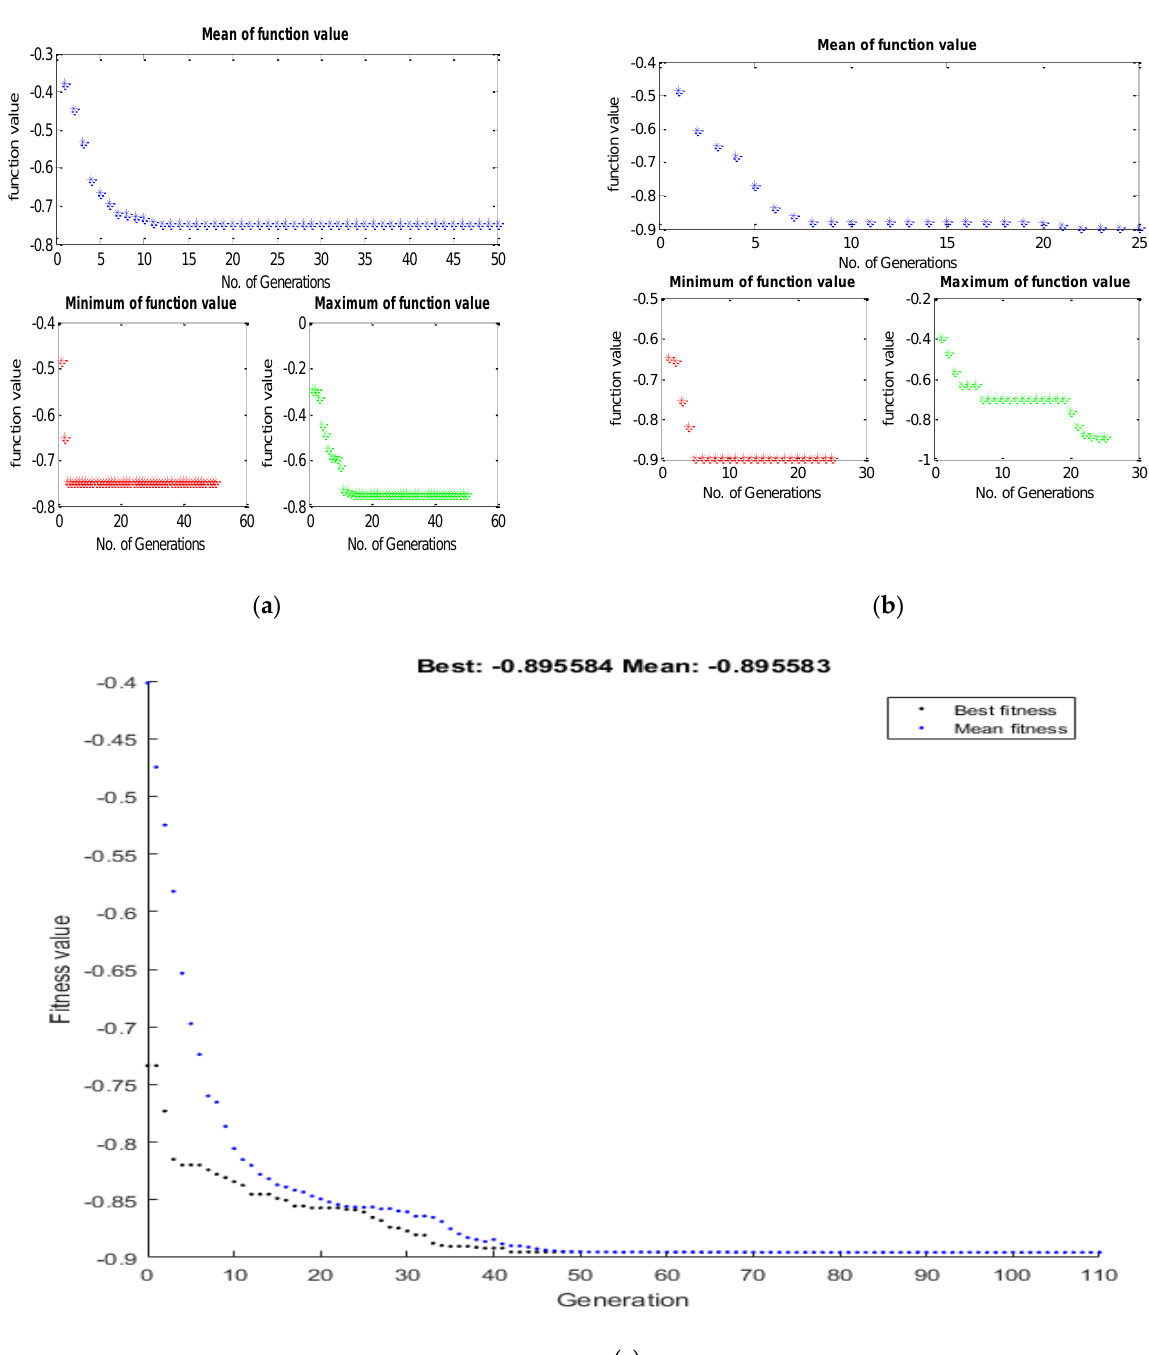
Figure 11. Convergence plot for the MPCI by ( a ) TLBO ( b ) JAYA & ( c ) Genetic Algorithm.